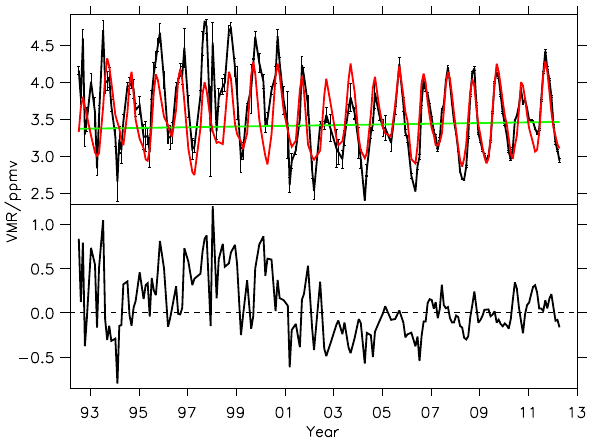
Figure 3. The merged time series (top panel, black curve) with the standard errors of the data (black) and the best fitting standard re- gression model (top panel, red curve) and the linear term of the regression (green line). In the lower panel the residual time series between the measured data and the fitted regression model is shown. The latitude bin of 0–10 ◦ S is shown for an altitude of 17km as an example. The residual (rms = 0.35ppmv) appears to have a system- atic harmonic component with a period of about 11